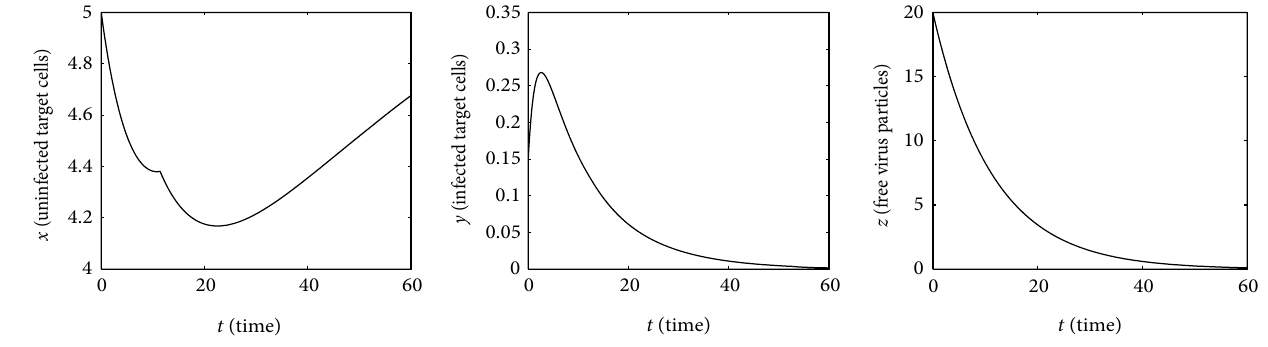
Figure 1: Optimal solutions for 푇 = 60.0 : 푥